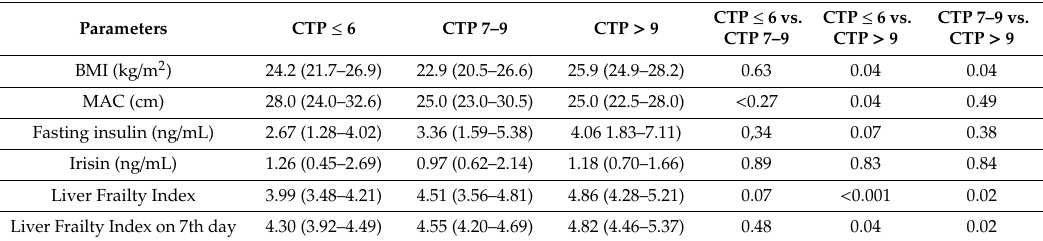
Table 4. Comparison of analyzed parameters with regards to the severity of cirrhosis, as assessed according to the Child-Pugh score.